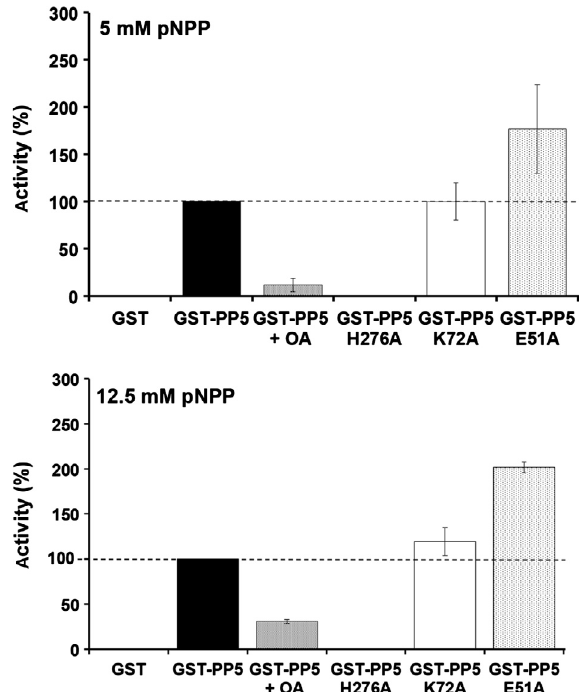
Figure 6. Biochemical characterization of GST-PP5 mutants. Phos- phatase activity was assessed at two different pNPP substrate concentrations simultaneously (5 mM and 12.5 mM, respectively) and absorbance was measured on a plate reader at 405 nm. Standard deviation is denoted by the bars shown ( n =